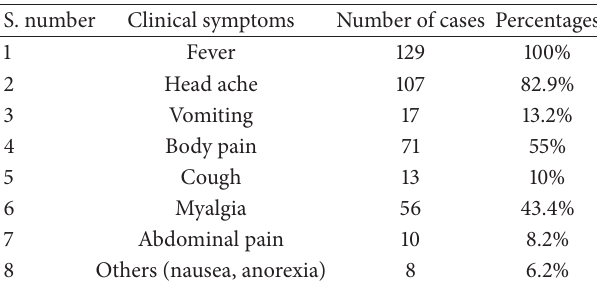
Table 5: Clinical symptoms of all the patients screened for lep-